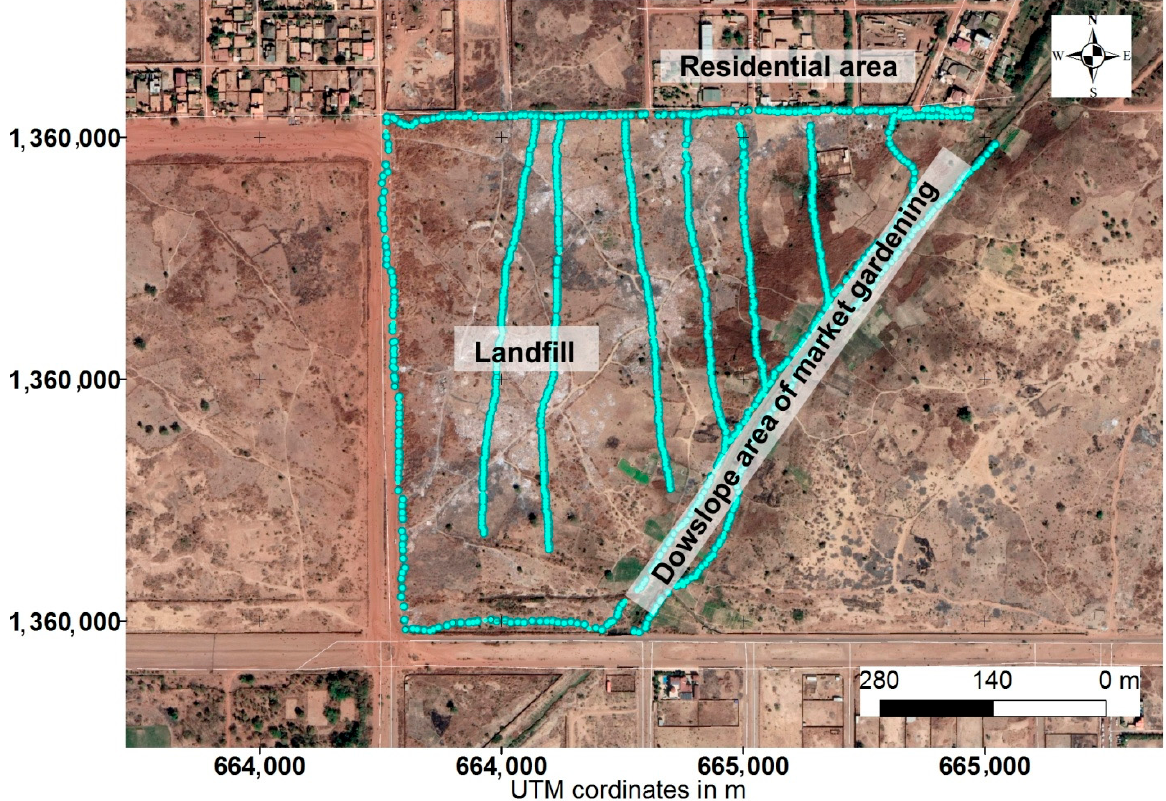
Figure 3. Location of the self-potential measurements sites (WGS84-UTM coordinate, zone 30N).